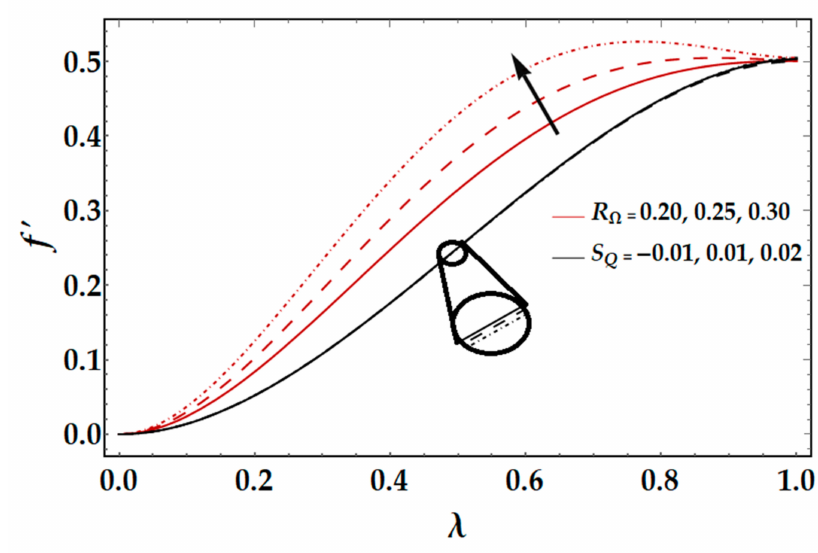
Figure 2. Implications of S Q and R Ω on velocity distribution (axial) f (cid:48) ( λ ) .